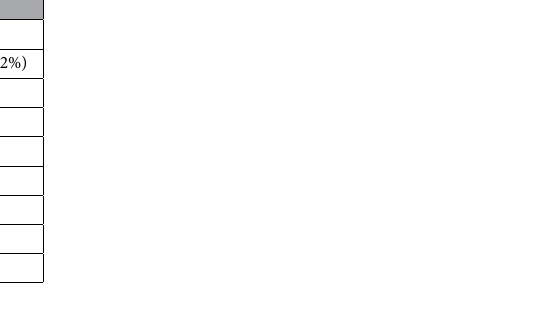
Table 1. Patient characteristics.